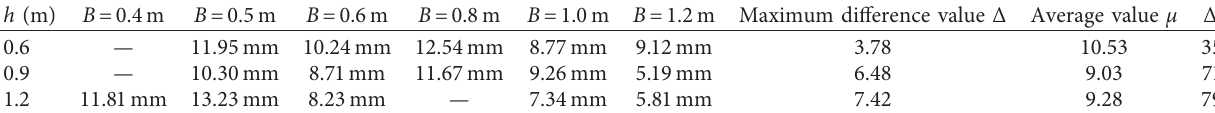
Figure 8: The variation curve of the deformation of rib pillars with the wall body at different widths B of the unloading board: (a) h � 0.6m, (b) h � 0.9m, and (c) h � 1.2m. Table 5: The maximum deformation of rib pillars at different widths B of the unloading